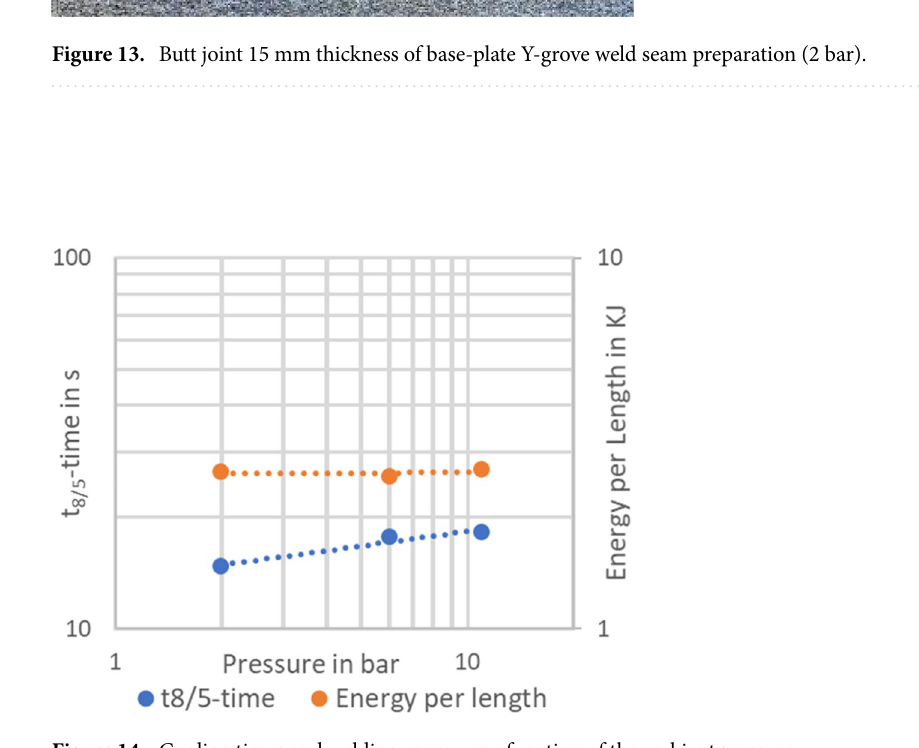
Figure 14. Cooling times and welding energy as a function of the ambient